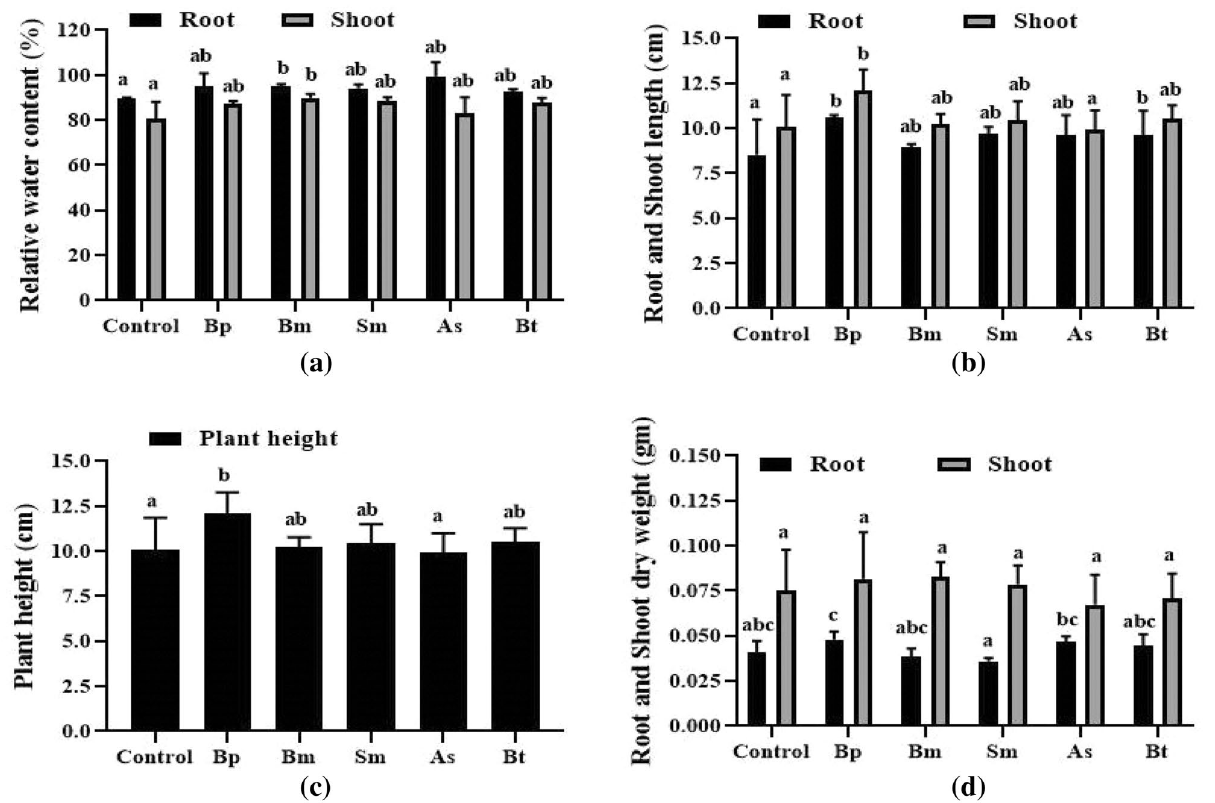
Figure 2. Morpho-physiological characteristics of wheat. Here, ( a ); indicates RWC content, ( b ); indicates root and shoot length, ( c ); indicates plant height and, ( d ); indicates root and shoot dry weight. Different letters indicate significant differences between mean ± SD of replications (n = 3) at a P < 0.05 significance